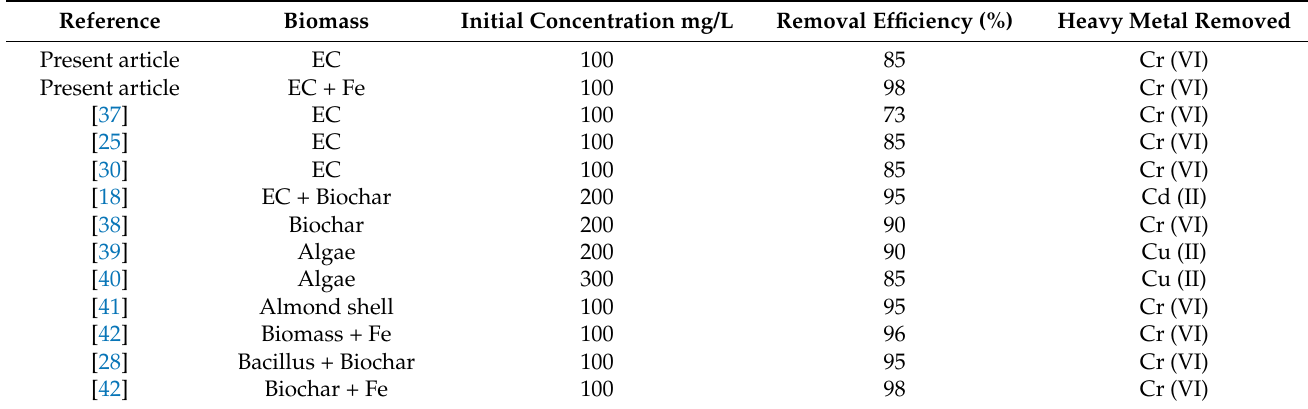
Table 1. Research with system in continuo with the different